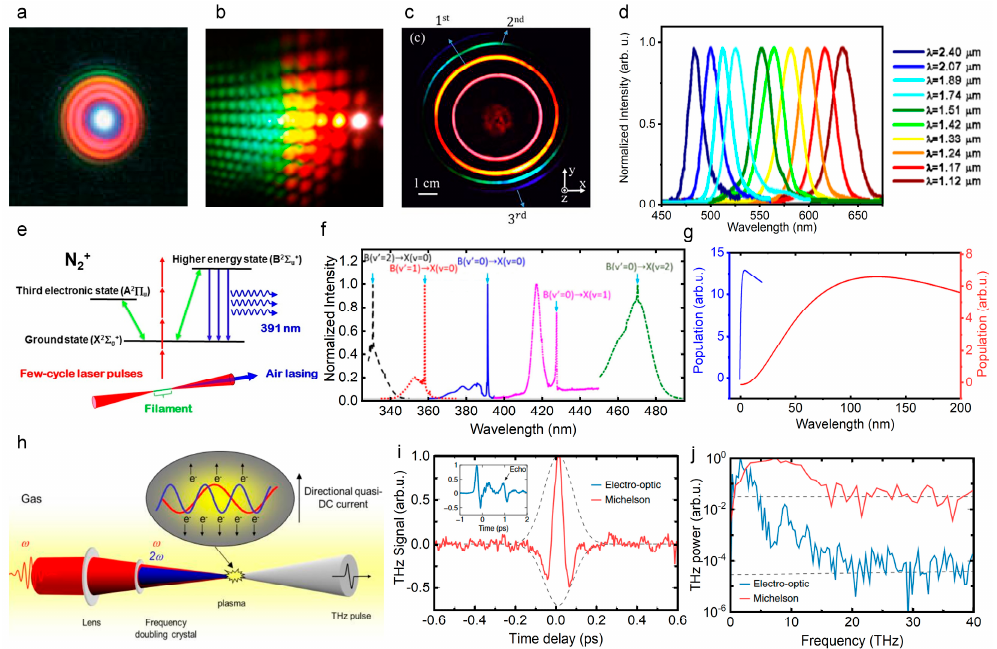
Figure 4. Ultrabroad spectra generation during filamentation. ( a ) Supercontinuum that is generated from femtosecond laser filamentation [11]. ( b ) Multi-color laser arrays that are generated in the sapphire crystals [82]. ( c ) Multi-color ring that is generated from the interaction between double femtosecond Bessel laser beams and silica [84]. ( d ) Tunable and stable ultrashort laser pulses in the visible spectrum are generated with high efficiency by a four-wave mixing process during the filamentation of near-infrared laser pulses in gases [39]. ( e ) Schematic image of the mechanism of the lasing action during filamentation in air where three electron states are involved [85]. ( f ) Spectra of N 2+ lasing radiation that is excited by the pump laser with different wavelengths (from left to right: 1682, 1760, 1920, 2050, 1415 nm) [86]. ( g ) Calculated formation dynamic of the C 3 Π u+ state molecules that are based on the electron impact mechanism (blue line) and the dissociative recombination mechanism (red line) for 1 bar [87]. ( h ) Schematic of strong THz pulse generation from two-color laser-produced gaseous plasma [88]. ( i , j ) Temporal waveform and spectrum of THz that is generated by two-color laser field